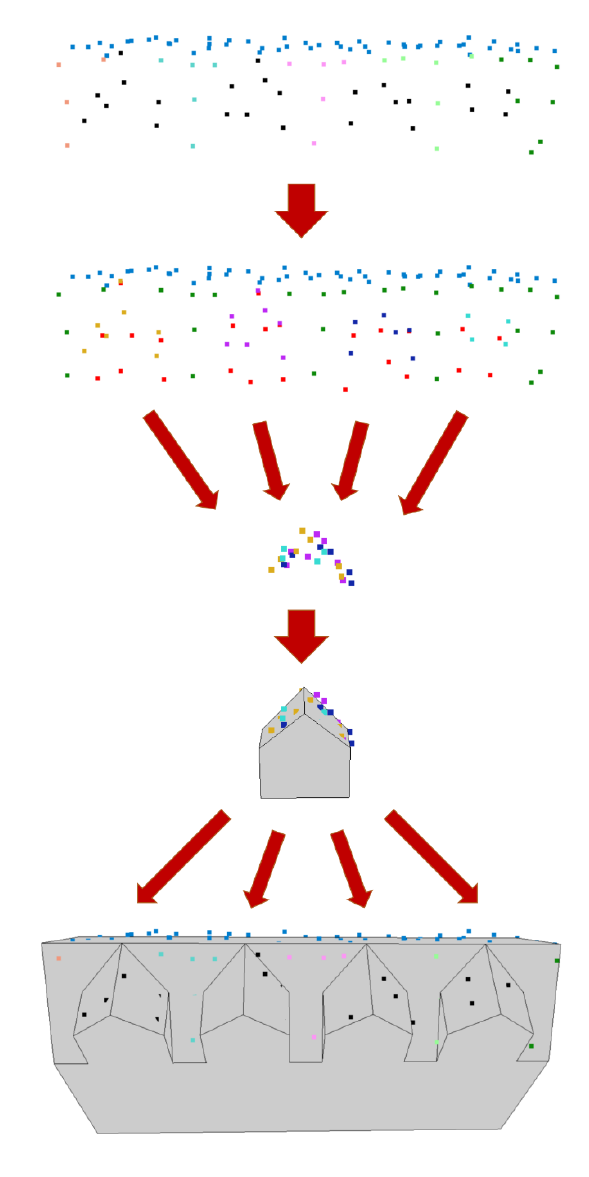
Figure 1. From top to bottom: segmentation result (unsegmented points in black); segmentation result after adding virtual points (red), and estimation of candidate areas; transformation result of the candidate points; roof superstructure reconstruction result; reconstruction result of the whole